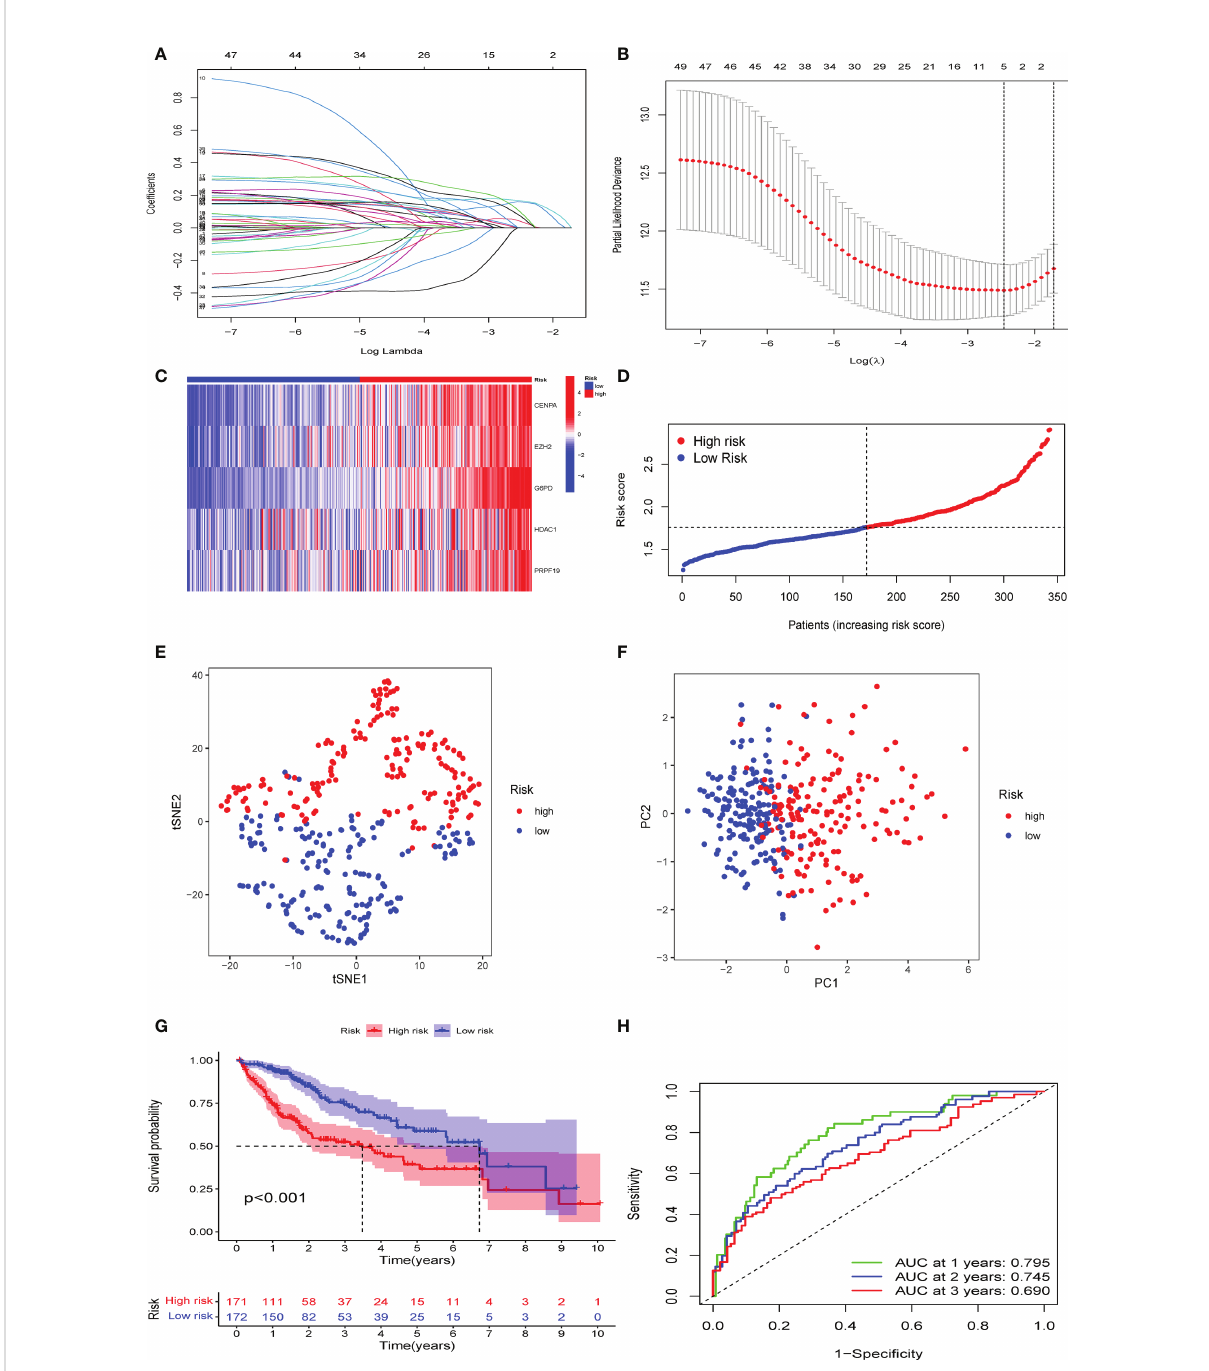
FIGURE 4 Establishment of a novel CS score signature. (A) Identi fi cation of the respective regression coef fi cients of 51 prognostic genes by lasso regression. (B) Lasso regression narrowed down the CS genes to create an optimal multivariate signature. (C) Heat map visualization of the trend of fi ve candidate genes in the training cohort with CS score. (D) The values of CSRG-based risk scores were distributed in each group of patients in the high-risk and low-risk groups. (E) PCA and (F) t-SNE reduction illustrated the patients in different risk groups were distributed in two directions. (G) Survival analysis results of patients of different risk groups in the training cohort. (H) Results of time-dependent ROC curves for the risk model in the training